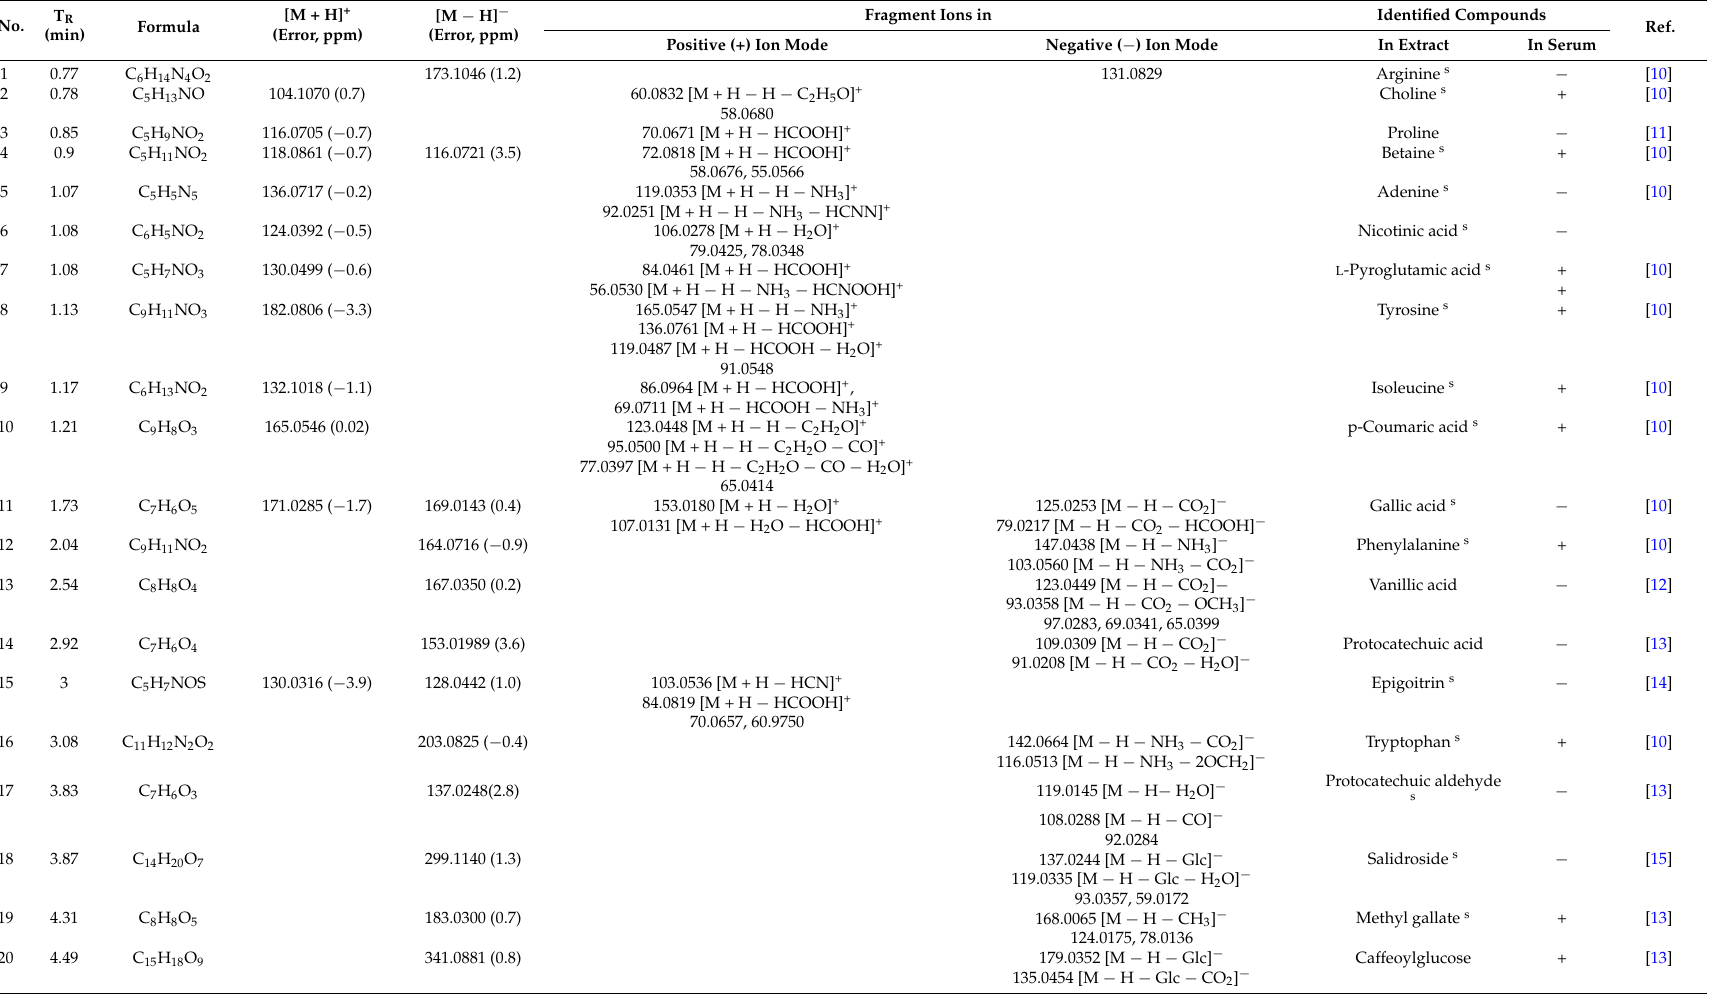
Table 2. Identified compounds in extract of HGKYC and in rat serum after oral administration of HGKYC in positive and negative ion